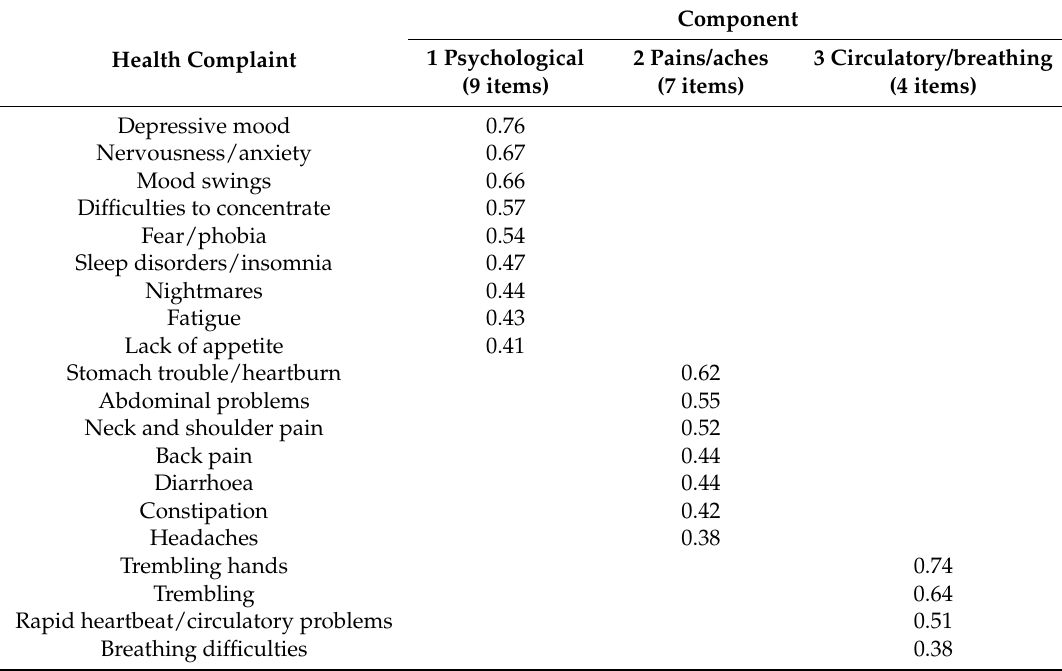
Table 2. Factor analysis of 20 health complaints into three